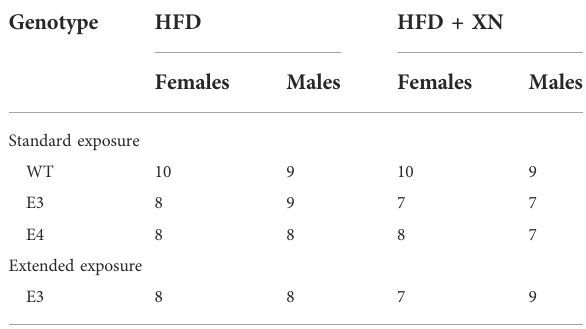
TABLE 1 The number of mice in the standard and extended exposure experiments.